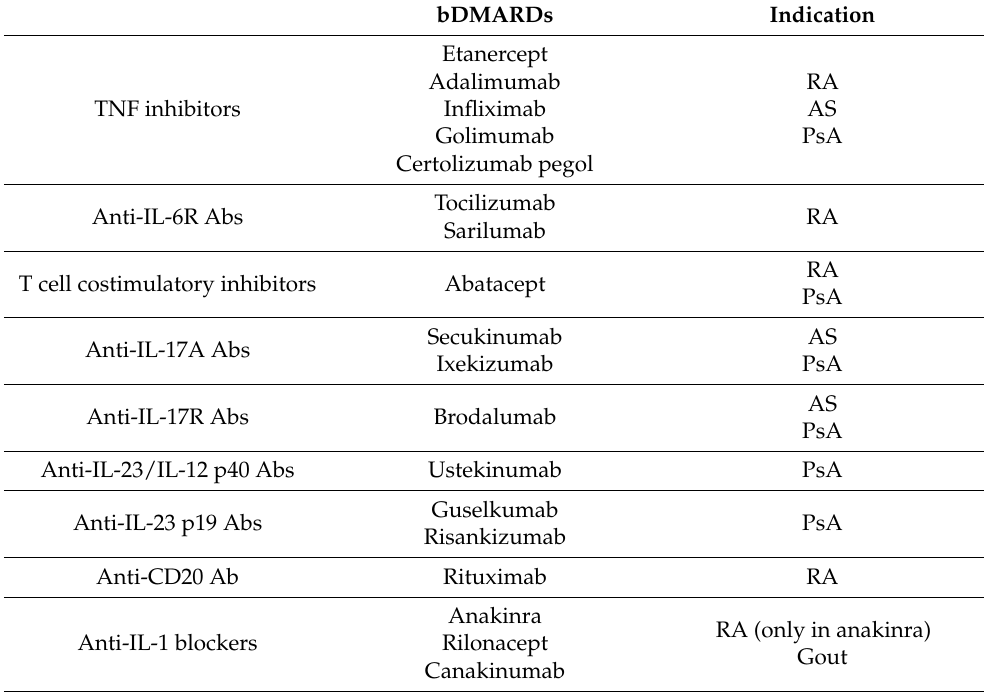
Table 1. Classification and indications for